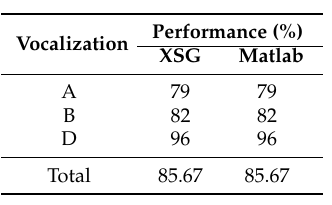
Table 2. Performances obtained with XSG and Matlab based implementations.